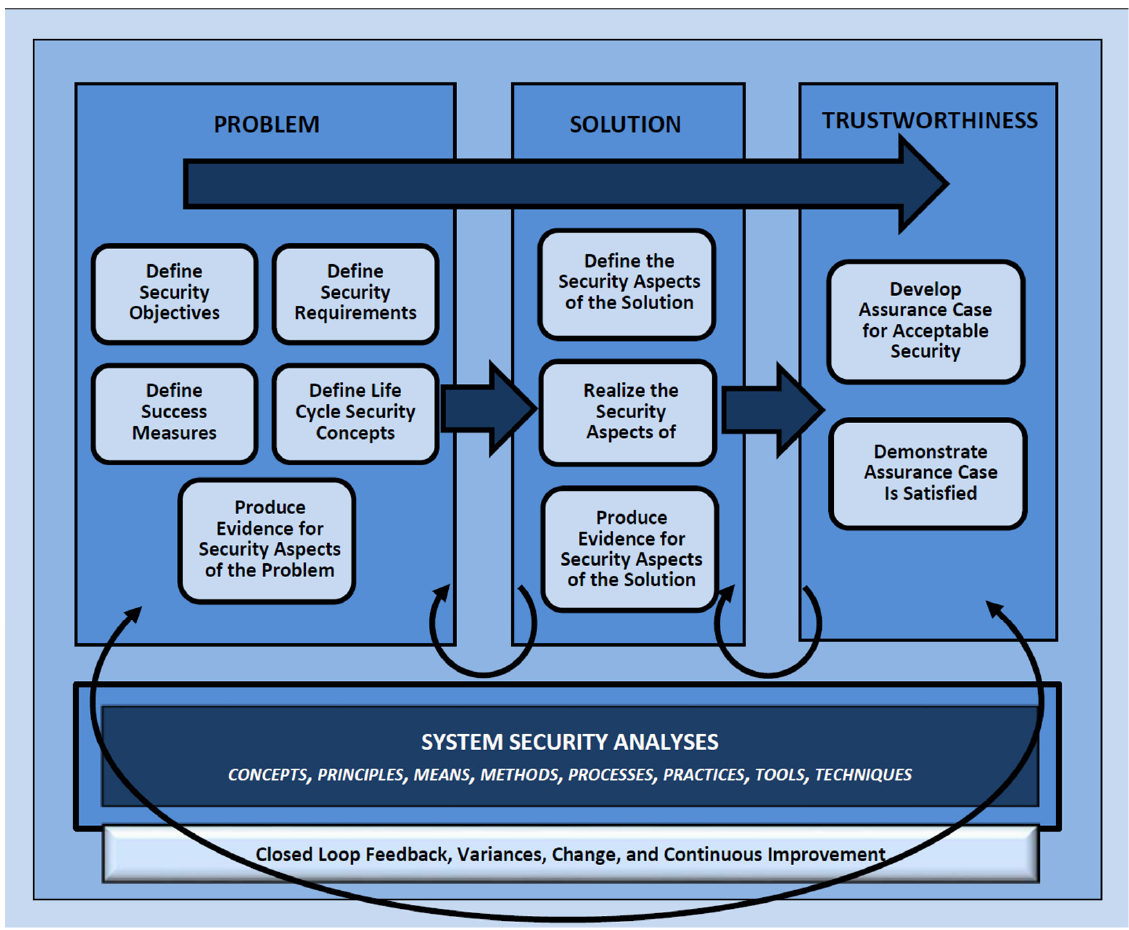
Figure 2. Top ‐ level view of NIST System Security Framework [22]. The framework in Figure 1 is one example of a type of security consideration contextualized for the SOI by this Security Framework.